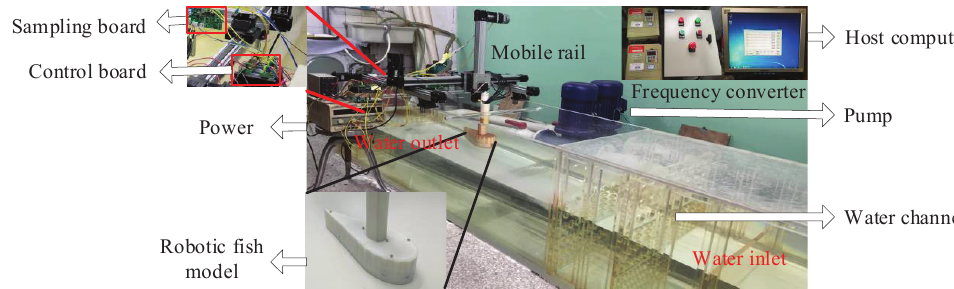
Figure 3. The experiment